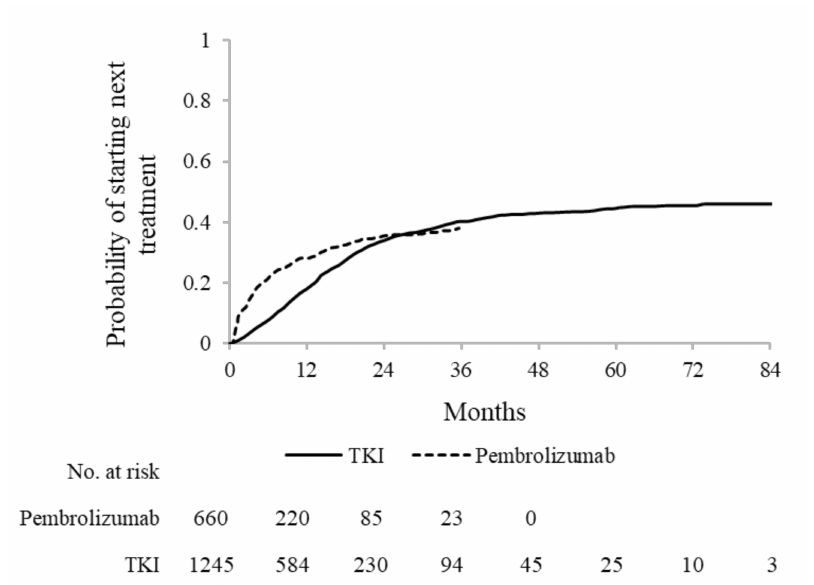
Figure 2. Kaplan-Meier estimates of time-to-next treatment among 660 and 1245 advanced NSCLC patients treated, respectively, with first-line pembrolizumab and tyrosine-kinase inhibitors (TKI).